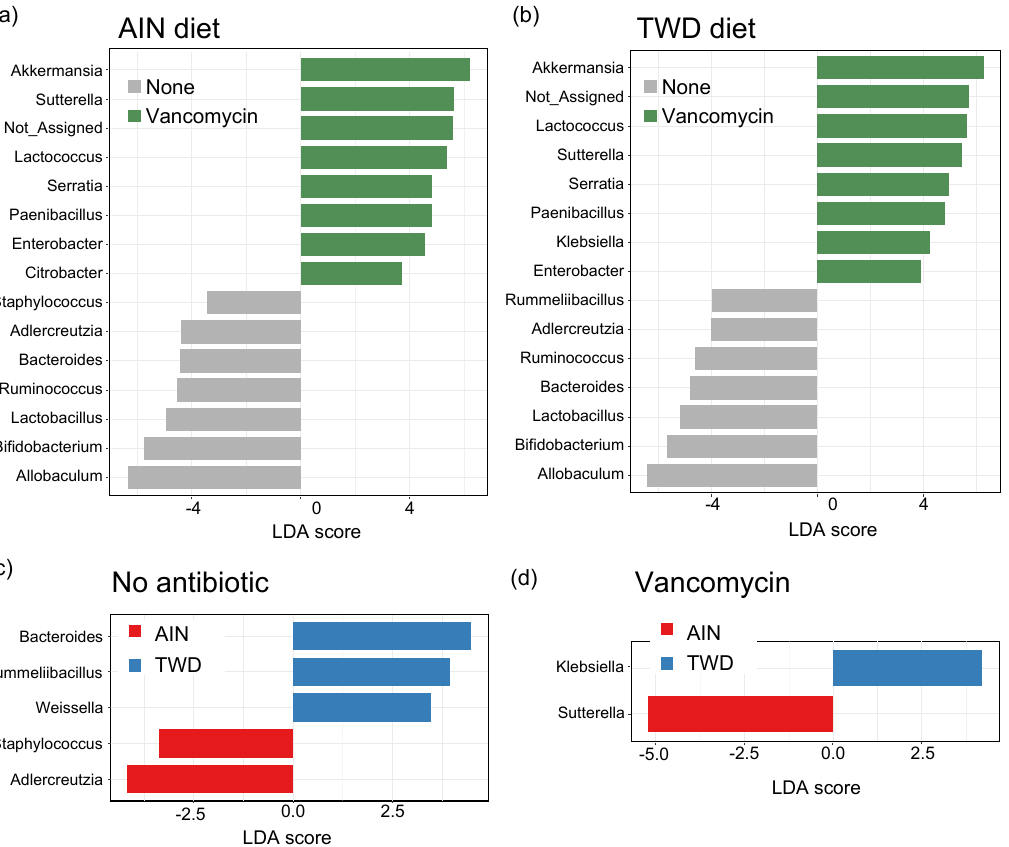
Figure 10. Identification of discriminating genera using linear discriminate analysis by effect size (lefse). Lefse analyses were performed to identify taxa discriminating the antibiotic treatment for mice were fed either AIN ( a ) or TWD ( b ) or to identify taxa discriminating the basal diet for no antibiotic ( c ) or vancomycin ( d ) treatment. Lefse analyses were performed at the genus taxa level with minimum score of 2.0 and FDR-adjusted p < 0.05. The top 15 discriminating genera are shown with the log 10 LDA score. Abbreviations: PCoA, principal coordinate analysis; AIN, the AIN93G diet; TWD, the total Western diet.